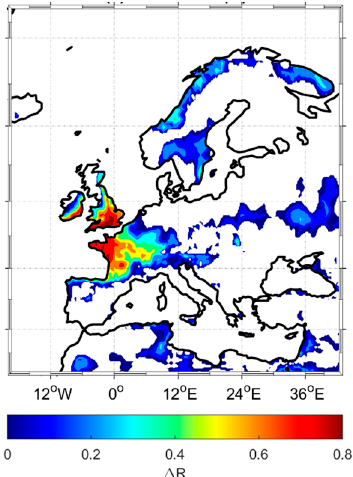
Figure 5. Spatial distribution of the difference ( ∆ R) between the correlations of the NAO index and the WEPA index with winter-averaged precipitation. the WEPA index with winter-averaged